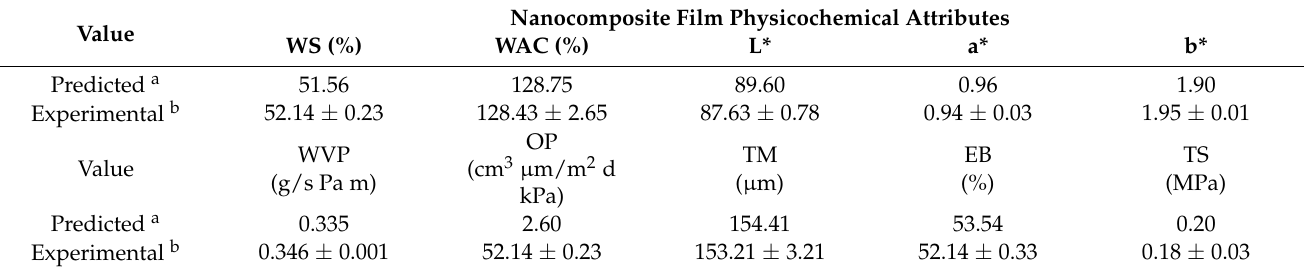
Table 7. Comparison of the experimental and predicted data for the investigated physicochemical properties of produced nanocomposite